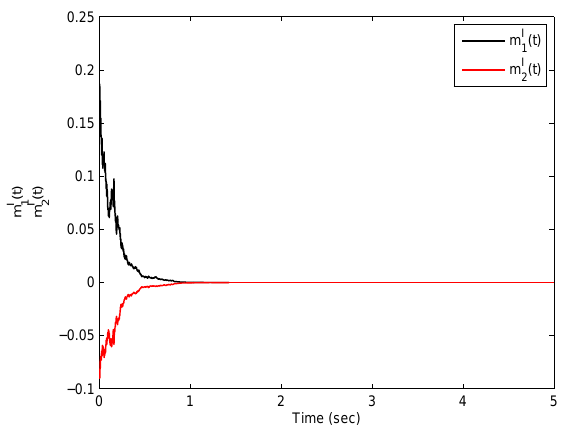
( t ) , m I ( t ) pertaining to the SMQVNN 2 1